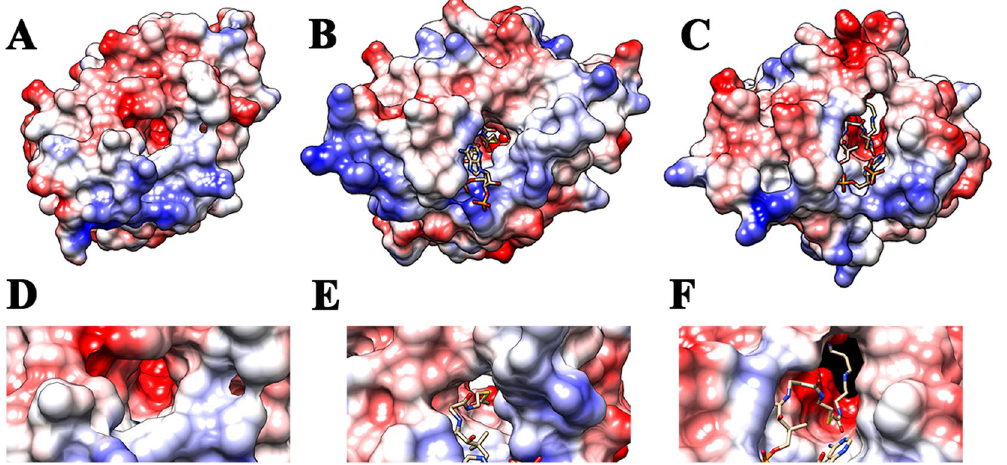
Figure 3. Comparison of the surface electrostatic potential of D. melanogaster AgmNAT to that of D. melanogaster AANATA and human SSAT. ( A ) AgmNAT (PDB code 5K9N). ( B ) D. melanogaster AANATA (PDB code 3TE4). ( C ) Human SSAT (PDB code 2JEV). ( D ) Close up of AgmNAT active site oriented to show the entry point for acetyl-CoA. ( E ) Close up of D. melanogaster AANATA active site with acetyl-CoA bound and oriented to show the entry point for acetyl-CoA. ( F ) Close up of the human SSAT active site with the bisubstrate inhibitor N 1 -spermine-acetyl-CoA bound and oriented to show the entry point for acetyl-CoA. Blue is for positive charges and red is for negative charges. Surface electrostatic potentials reveal that the amine binding pocket for AgmNAT and SSAT are more negatively charged than the arylalkylamine binding pocket of